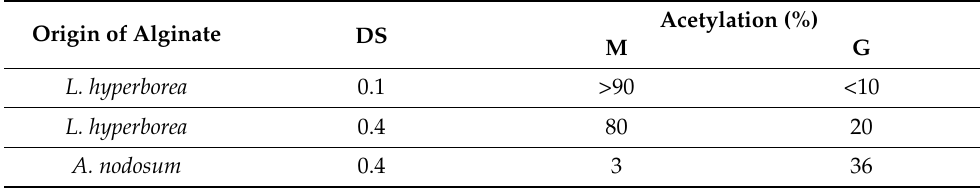
Table 2. Substitution ratio of acetyl residues in blocks M and G.